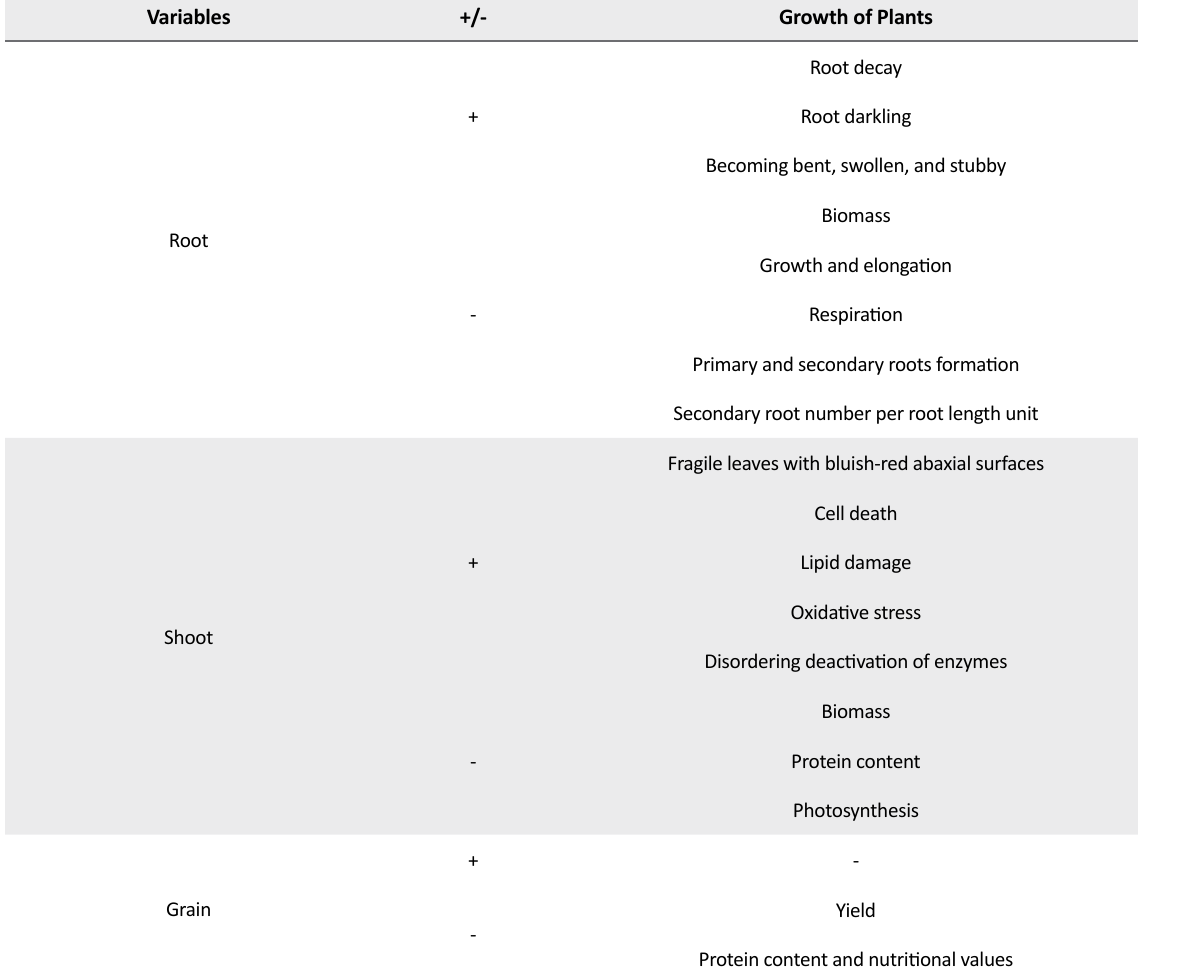
Table 1. Some important effects of Pb toxicity on growth of plants [4, 5, 17, 22-24]